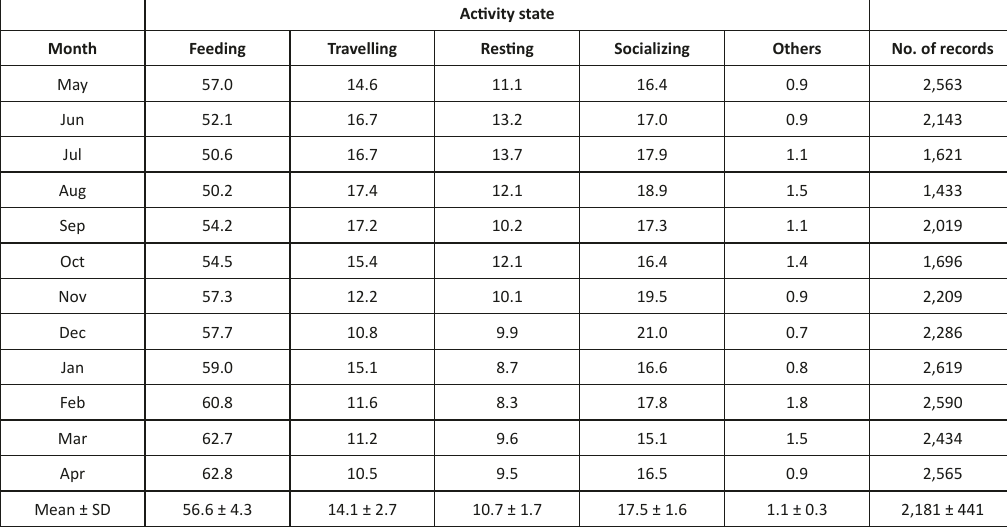
Table 1. Monthly time budgets as the percentage of time spent in each activity state